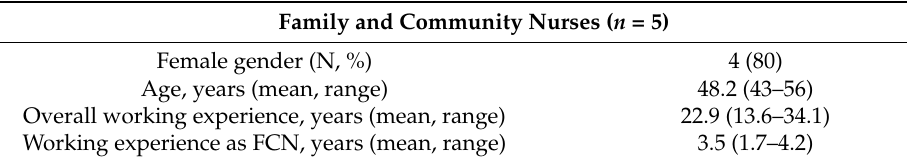
Table 1. Participants’ characteristics.